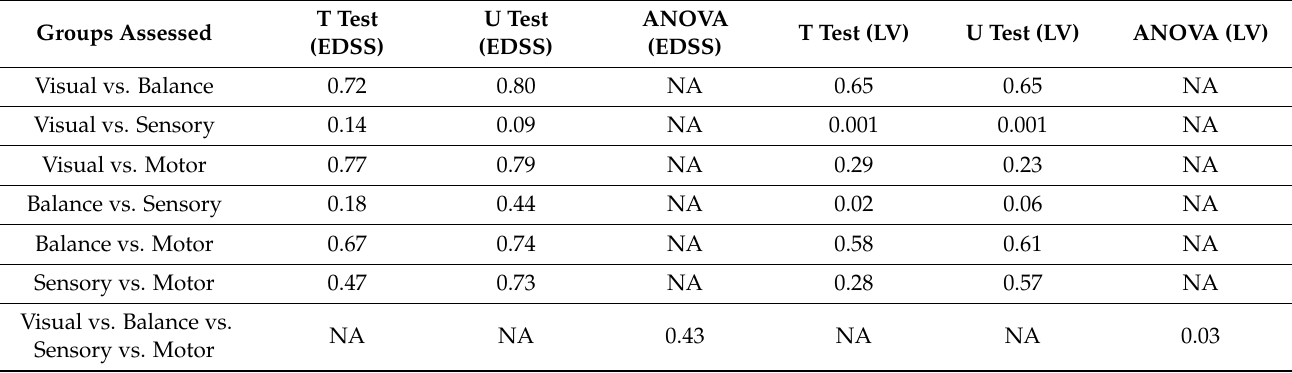
Figure 3. Average Lesion Volume (mm 3 ) In All Presenting Symptom Groups. The average lesion volumes in the Balance (16,377.06 mm 3 ) and Visual (18,297.72 mm 3 ) groups were significantly different than the average lesion volume of the Sensory (7034.21 mm 3 ) group. No significant differences were determined when comparing average lesion volume of the Motor (12,383.10 mm 3 ) group with the other three presenting symptom groups. Error bars represent the standard error of the mean in the Balance (3821.22mm 3 ), Visual (2290.53 mm 3 ), Motor (6468.12mm 3 ), and Sensory (1208.95 mm 3 ) groups. Table 2. Overview of comparisons between presenting symptom groups. T-tests, U-tests, and ANOVA tests were performed to compare EDSS scores and lesion volumes across presenting symptom groups. Significant differences were seen when comparing lesion volume in the Visual and Sensory groups, lesion volume in the Balance and Sensory groups, and lesion volume in all groups ( p <